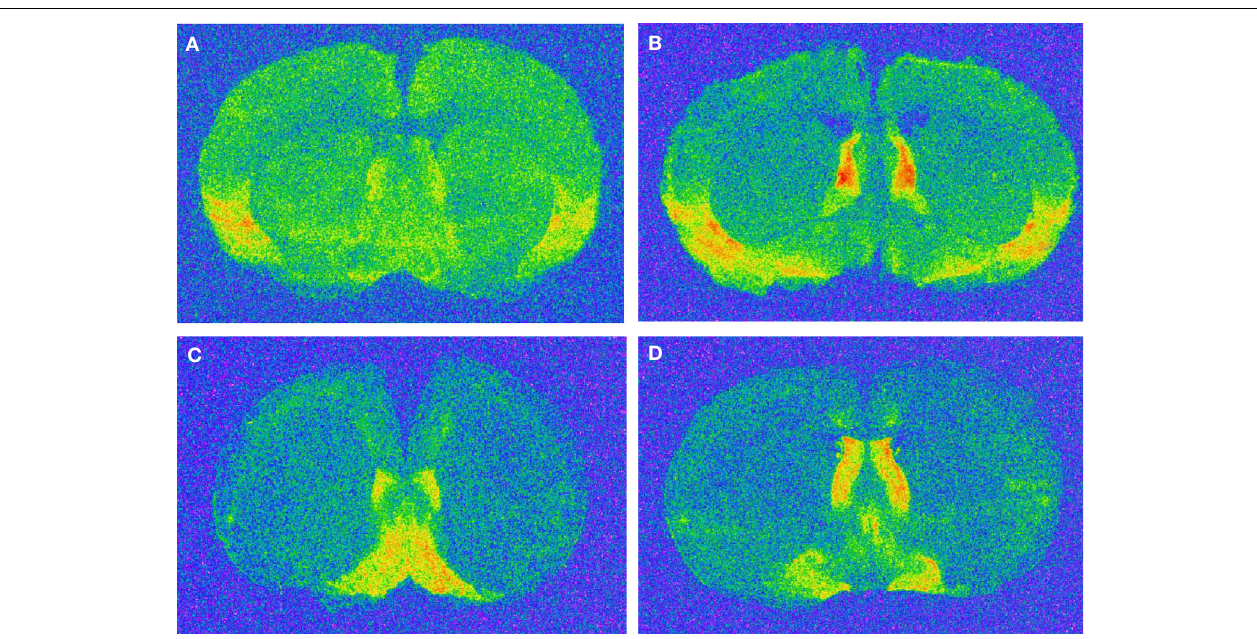
FIGURE 6 | Representative images of regions with oxytocin and vasopressin V1a receptor binding. (A) rostral oxytocin receptor; (B) caudal oxytocin receptor; (C) rostral vasopressin V1a receptor; (D) caudal vasopressin V1a receptor. Please refer to materials and methods for co-ordinates and